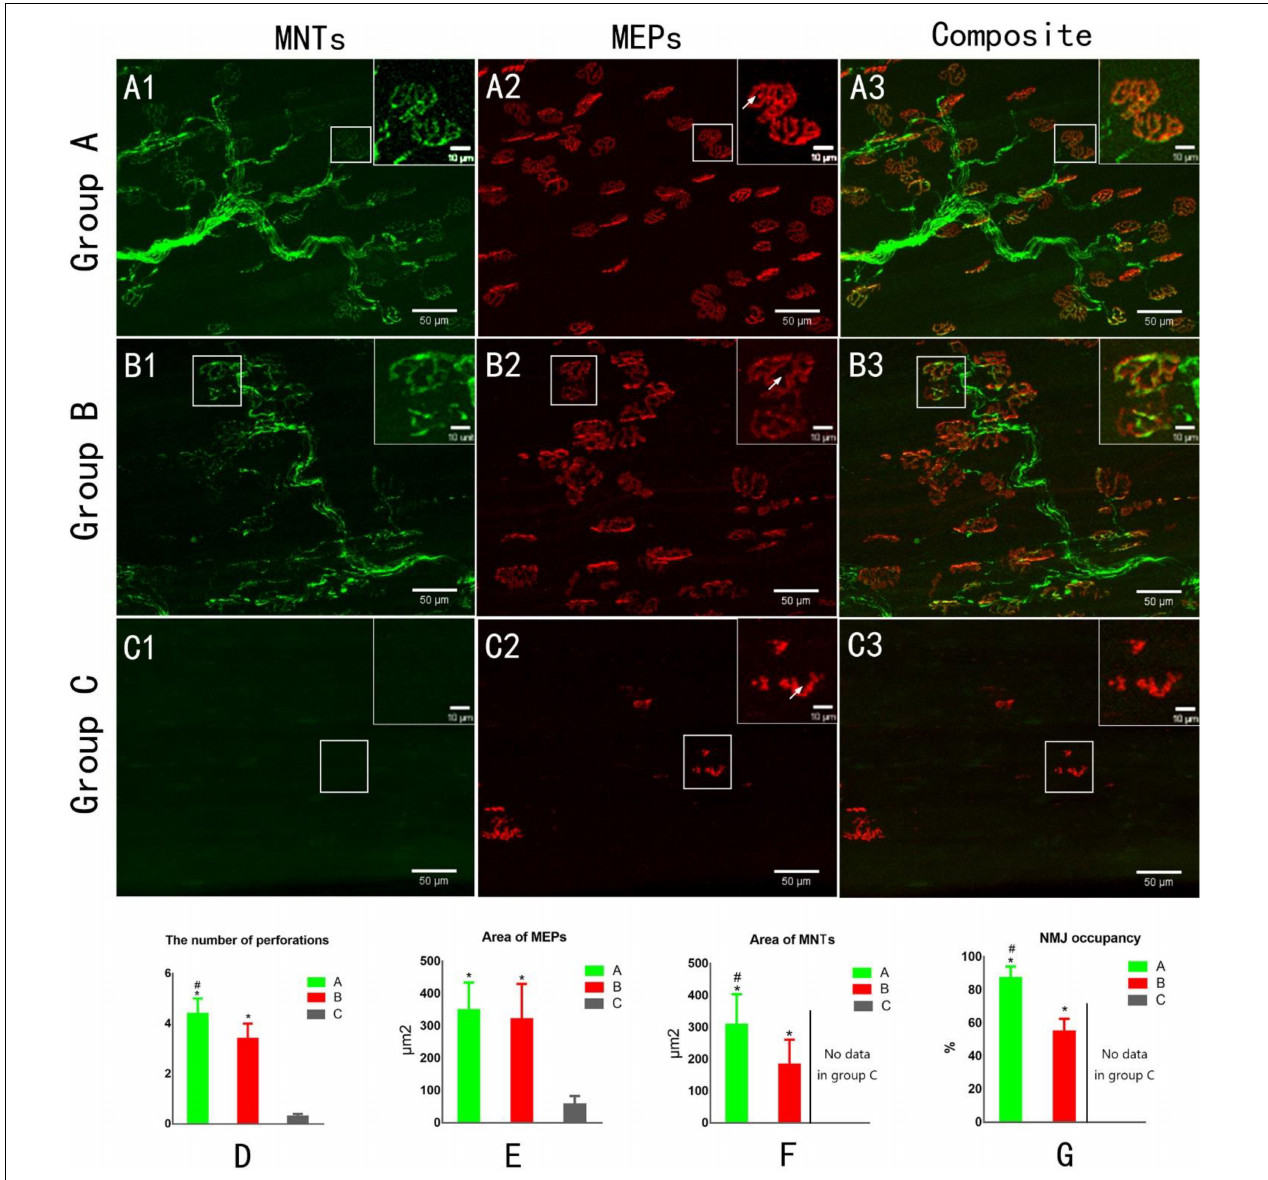
FIGURE 4 | Confocal microscopy to assess reinnervation of NMJs (A1,B1,C1) . The yellow fluorescent protein is visualized in motor axons to demonstrate motor nerve terminals (MNTs) (A2,B2,C2) . Motor endplates (MEPs) are stained with a-bungarotoxin (A3,B3,C3) . Composite images of MNTs and MEPs. MEPs appear “pretzel-shaped” both in groups A and B. The MEPs are degenerated, appearing “plaque-shaped,” and no MNT signals are detected in Group C (C1–C3) . White arrows indicate the perforation of MEP (A2,B2,C2) . (D) The number of perforations per MEP. (E) The area of MEPs. (F) The area of MNTs. (G) NMJ occupancy (MNT area/MEP area × 100%). * p < 0.05 vs. C group, # p < 0.05 vs. B group. (A, normal control group; B, proximal peroneal nerve-repaired distal tibial nerve group; and C, unrepaired tibial nerve group, n = 6 for each group, bars =